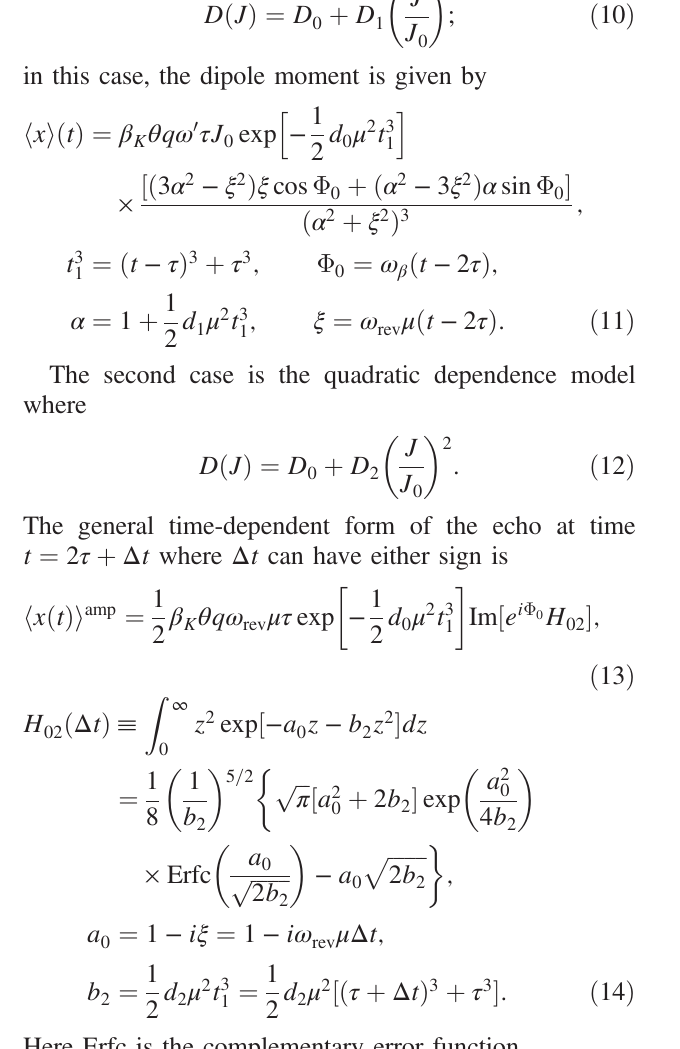
Here Erfc is the complementary error function.